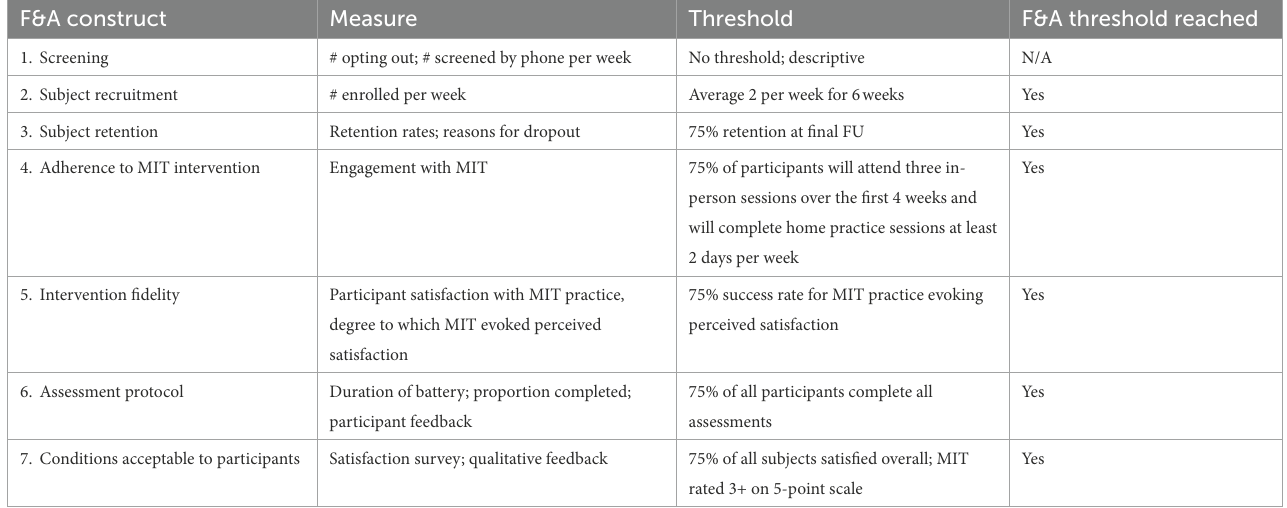
TABLE 1 Feasibility and acceptability of MIT trial procedures and